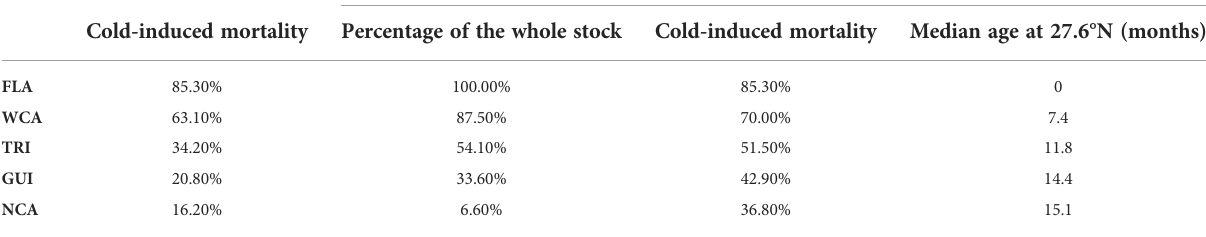
TABLE 5 Cumulated cold-induced mortality rates (at the end of the simulation) in the different stocks together with the correlated parameters of the main Caribbean dispersal group (percentage of individuals and cold-induced mortality in that group, median age of these individuals when reaching